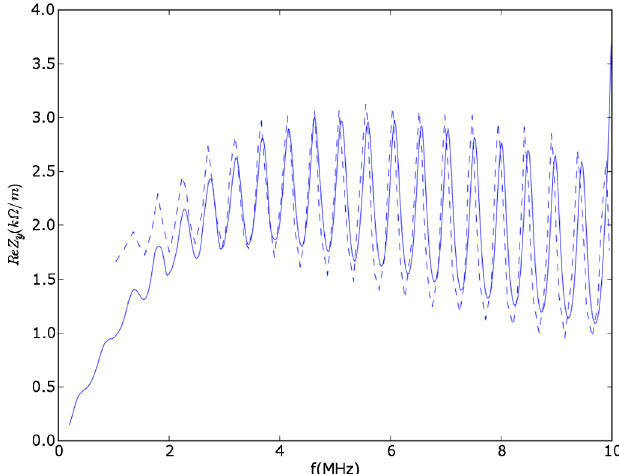
FIG. 7. (Color) Real part of Z vs frequency of the SNS kicker y prototype with the actual PFN, connected to the kicker by 200 m long 50 (cid:2) cables. Dashed line: direct measurements [4], Fig. 17 (‘‘no screen’’). Solid line: simulation results obtained from the parametrization, Eq. (15), see